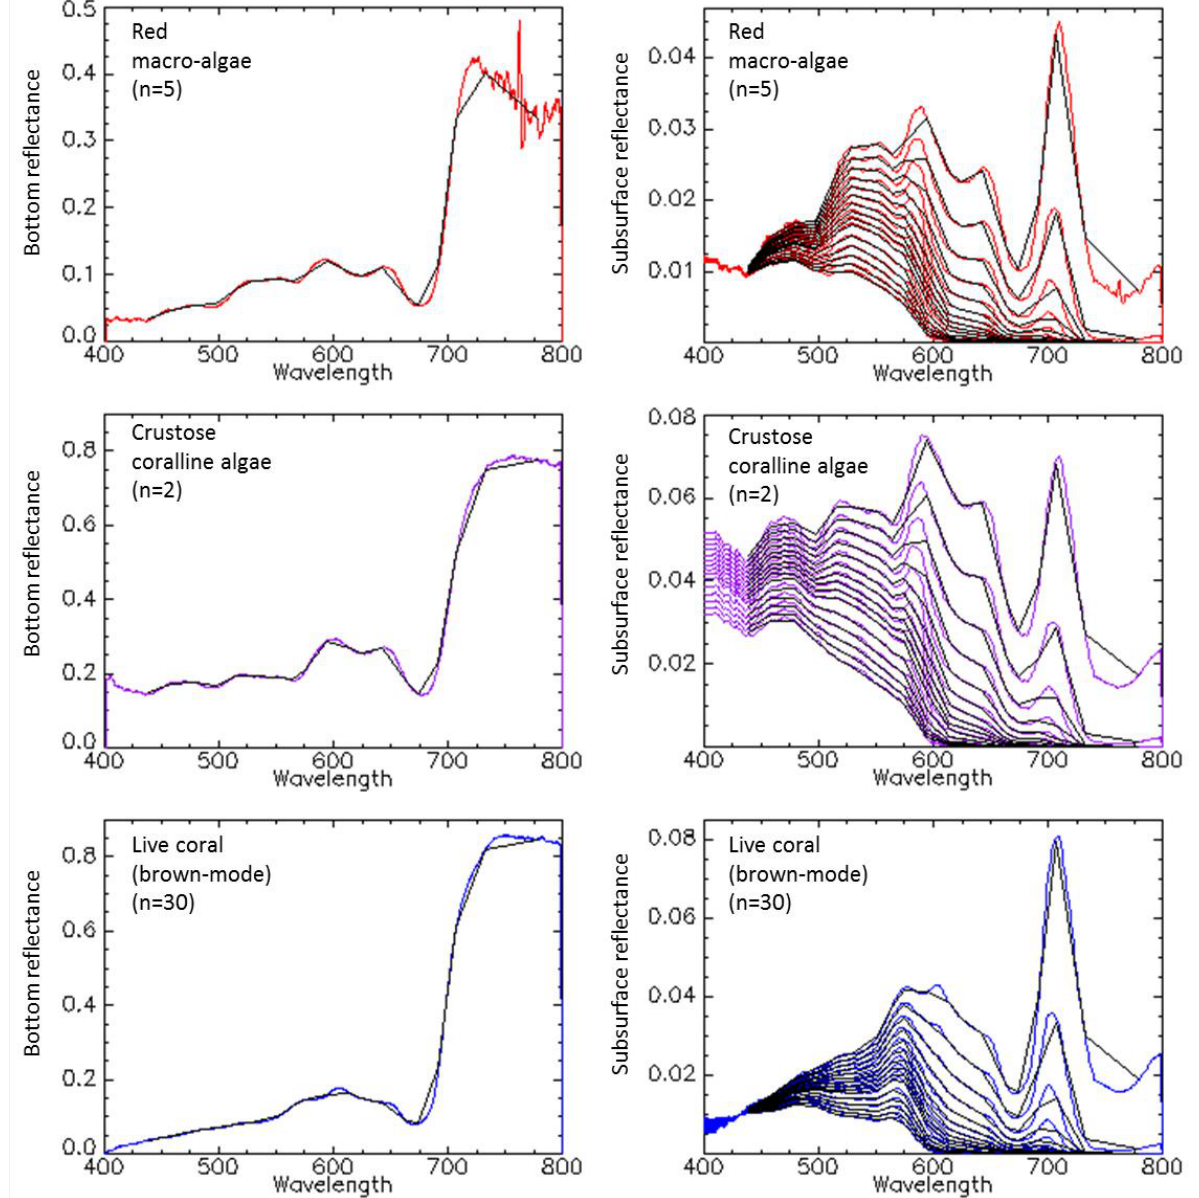
Figure 9. The left column shows spectral reflectance signatures measured in-situ with negligible water column attenuation for red macro-algae, crustose coralline algae, and live coral (brown-mode). The coloured lines represent the full resolution (400–800 nm) spectra, and the black lines represent the corresponding curves integrated across spectral response curves of the CASI-2 sensor. The CASI-2 sensor was able to capture the (complex) spectral reflectance features that characterise these benthos and substrates. In comparison, many of these features were not captured when the subsurface reflectance spectra were integrated across the spectral response curves of the CASI-2 sensor (right column, taken from Figure